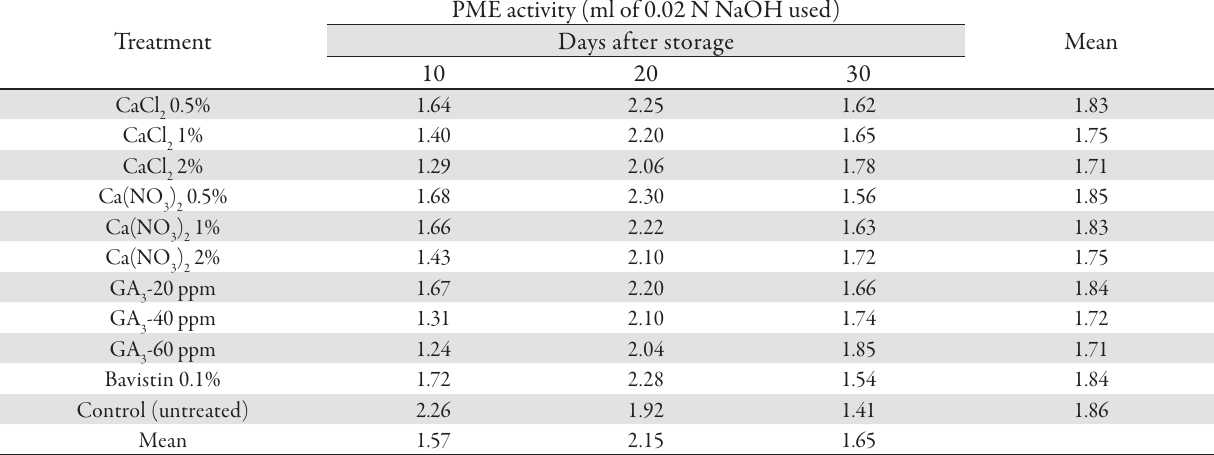
Tab. 4. Effect of different post-harvest treatments on pectin methyl esterase (PME) activity in ber fruits during cold storage